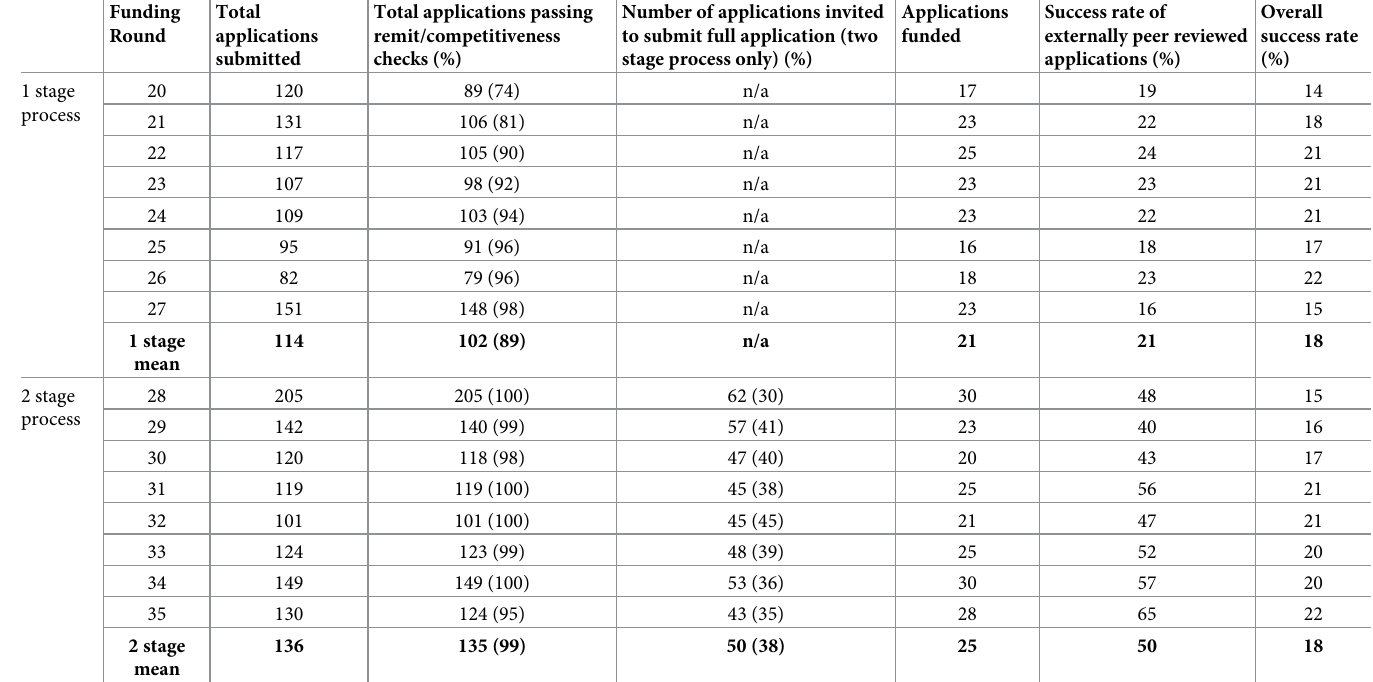
Table 2. Total applications and success